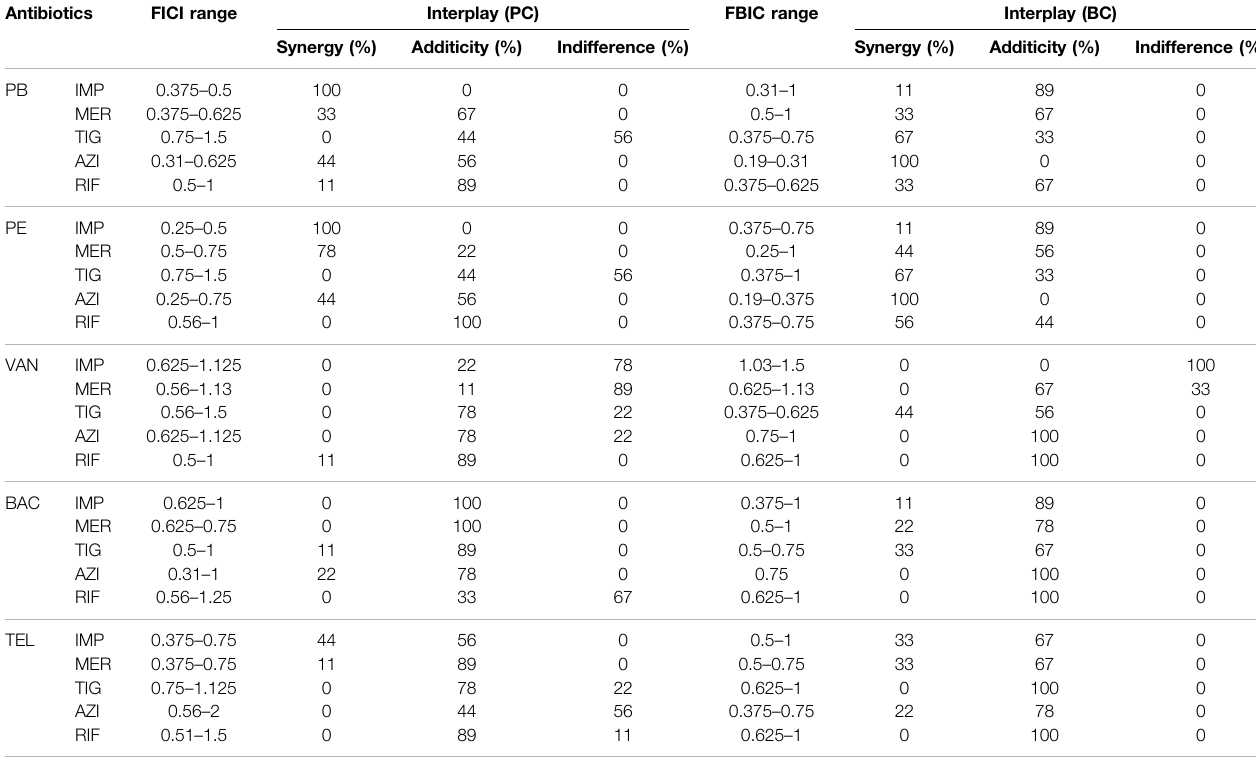
TABLE2| Antibacterialeffectof5peptideantibioticsincombinationwith5antimicrobialsonextensivelydrug-resistant A.baumannii isolates( n =9)intheplanktoniccell(PC) and bio fi lm cell (BC).